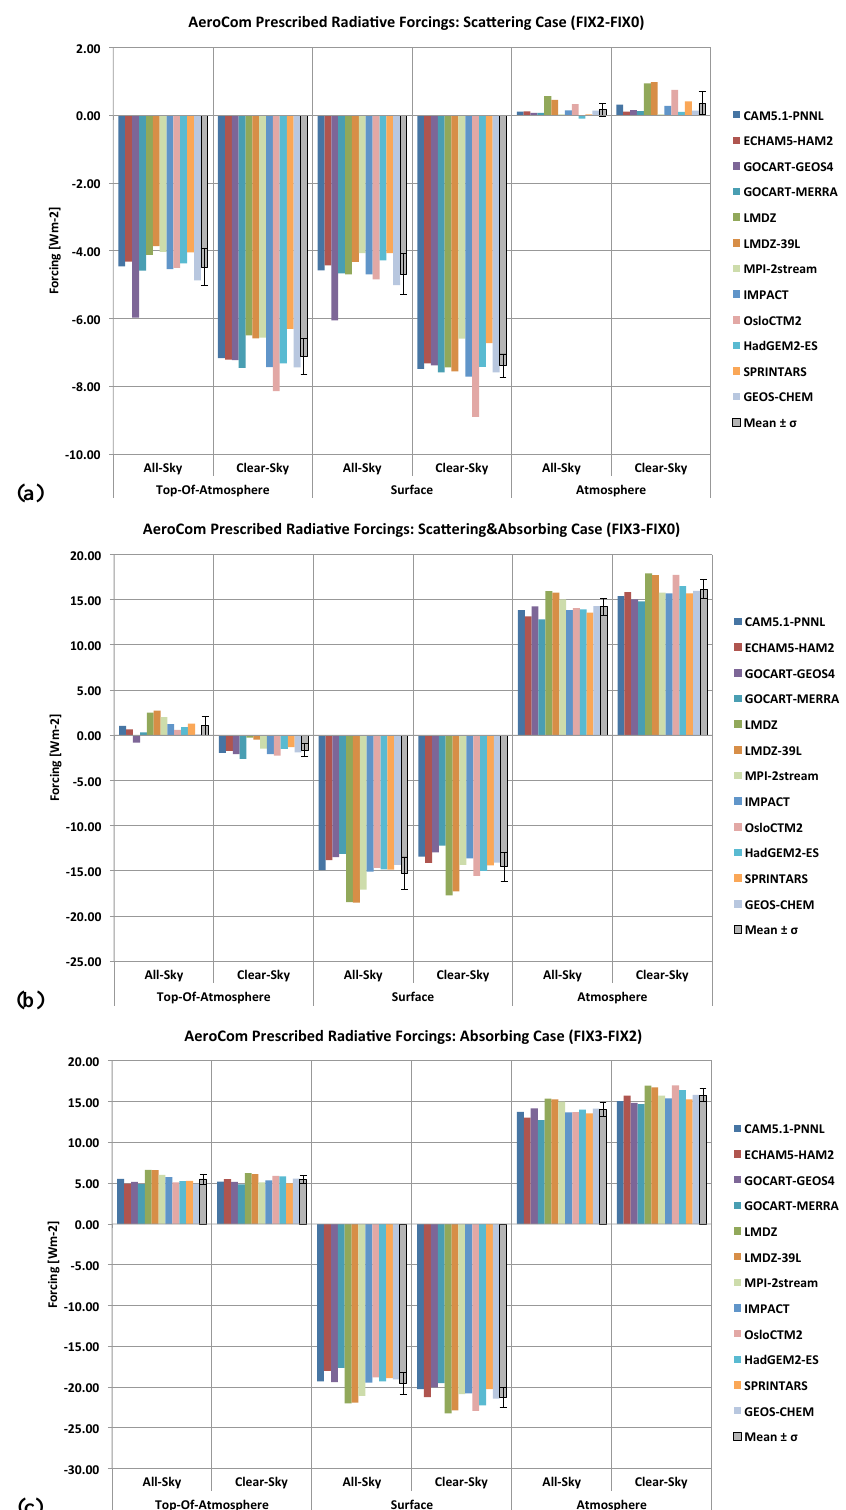
Fig. 16. Annual global-mean short-wave clear-sky and all-sky top-of-atmosphere, surface and atmospheric radiative forcing (absorption) between (a) experiments with AOD=0.2 and AOD=0.0 for SSA=1.0, (b) experiments with AOD=0.2 and AOD=0.0 for SSA=0.8 and (c) experiments with AOD=0.2 for SSA=0.8 and